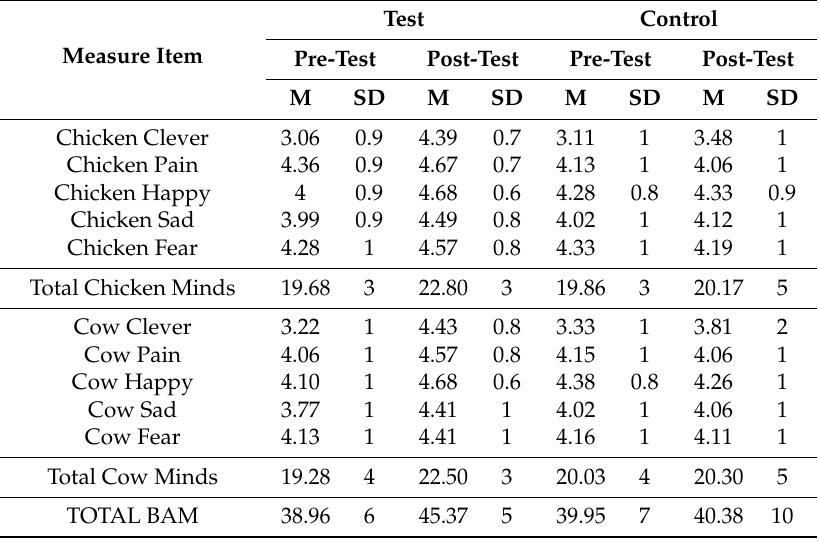
Table 3. Descriptive statistics for children’s beliefs about farm animal minds (BAM).